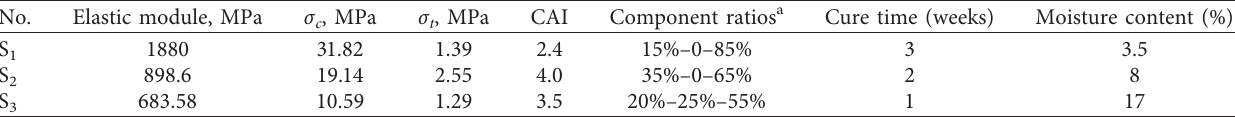
Table 1: Mechanical properties and component ratios of the